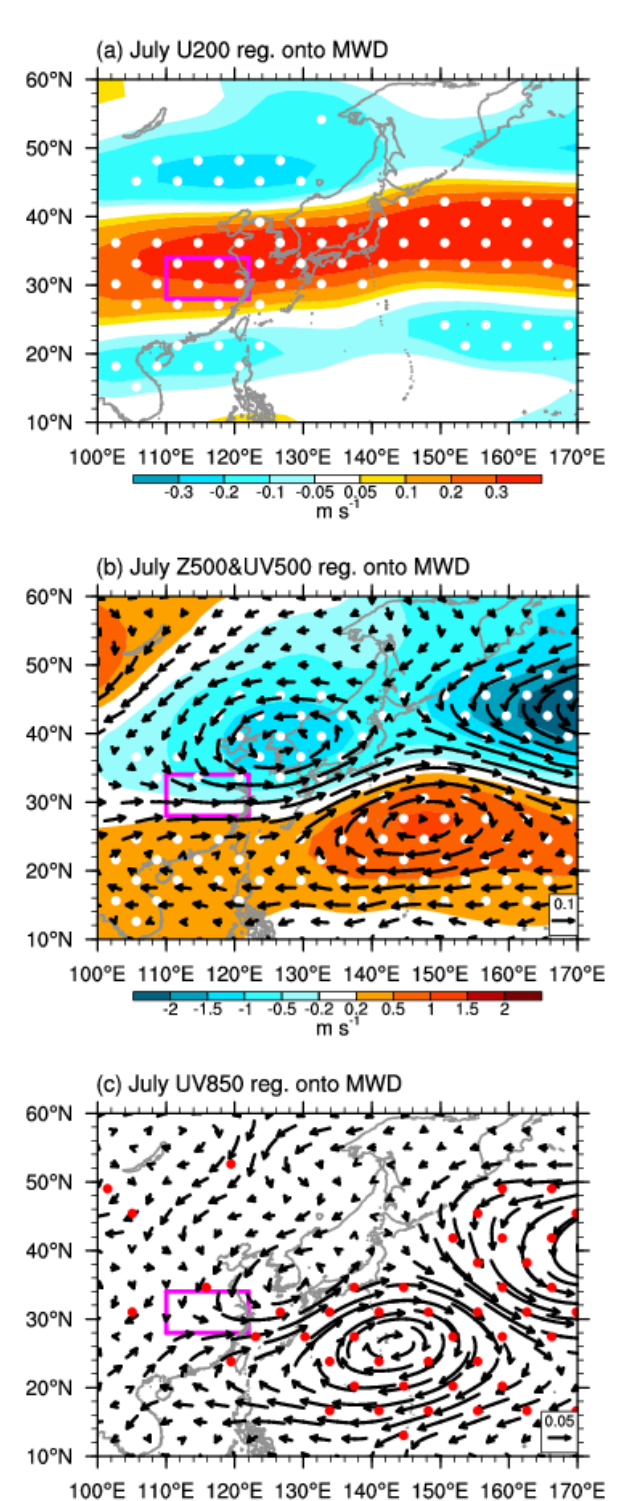
Figure 2. Regressed anomalies of July–mean ( a ) 200 hPa zonal wind (U200; shading; unit: m s − 1 ); ( b ) 500 hPa wind field (UV500; vectors; unit: m s − 1 ) and geopotential height (Z500; shading; unit: gpm); and ( c ) 850 hPa wind field (UV850; vectors; unit: m s − 1 ), with respect to the MWD departure in the YHRB during the period 1980–2016. U200, Z500, and UV850 anomalies that are significant at the 95% confidence level are stippled, and the magenta box denotes the research domain of the YHRB Meiyu region (28° N–34° N, 110° E–122° E) [16].